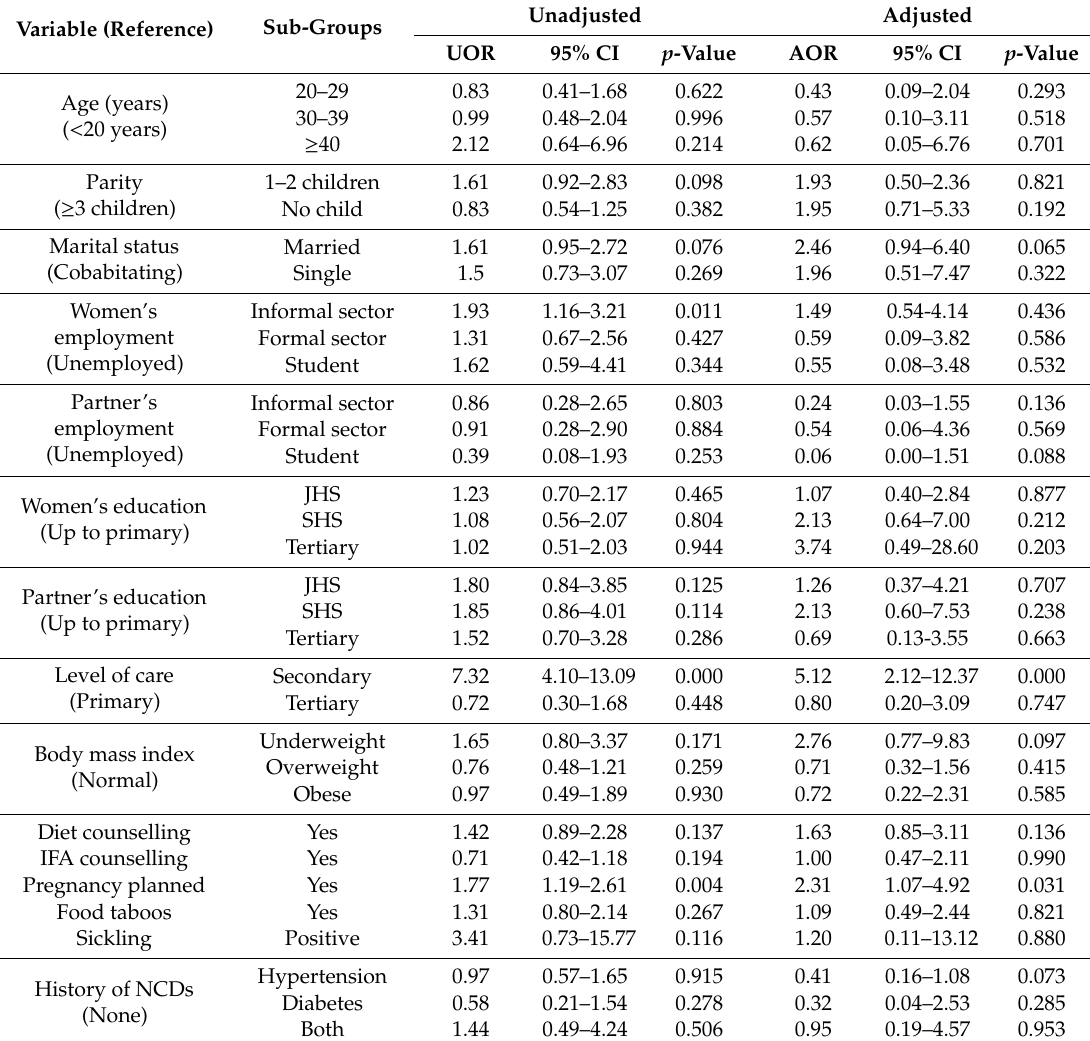
Table 2. Binary logistic regression showing the determinants for meeting the minimum dietary diversity